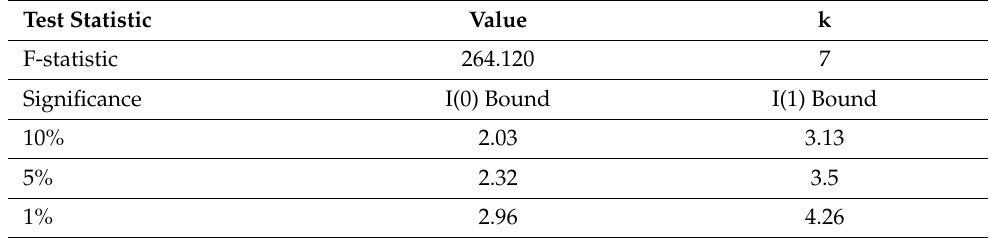
Table 6. NARDL Bounds